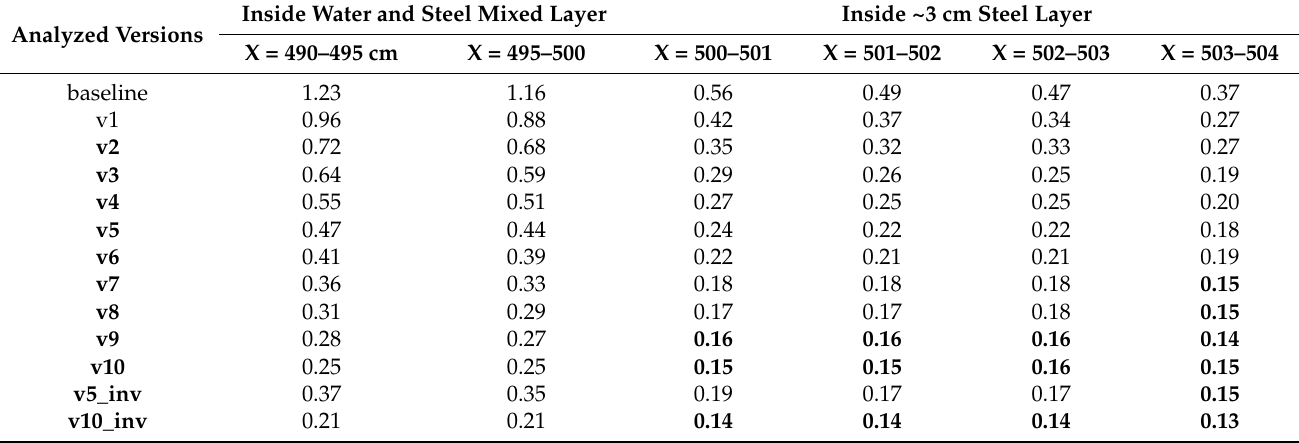
Table 5. Helium production (appm He/FPY) at the first 3 cm of the VV steel layer and inside the water and steel layer in which the peak was located for the baseline model, versions v1–v10, and v5_inverted and